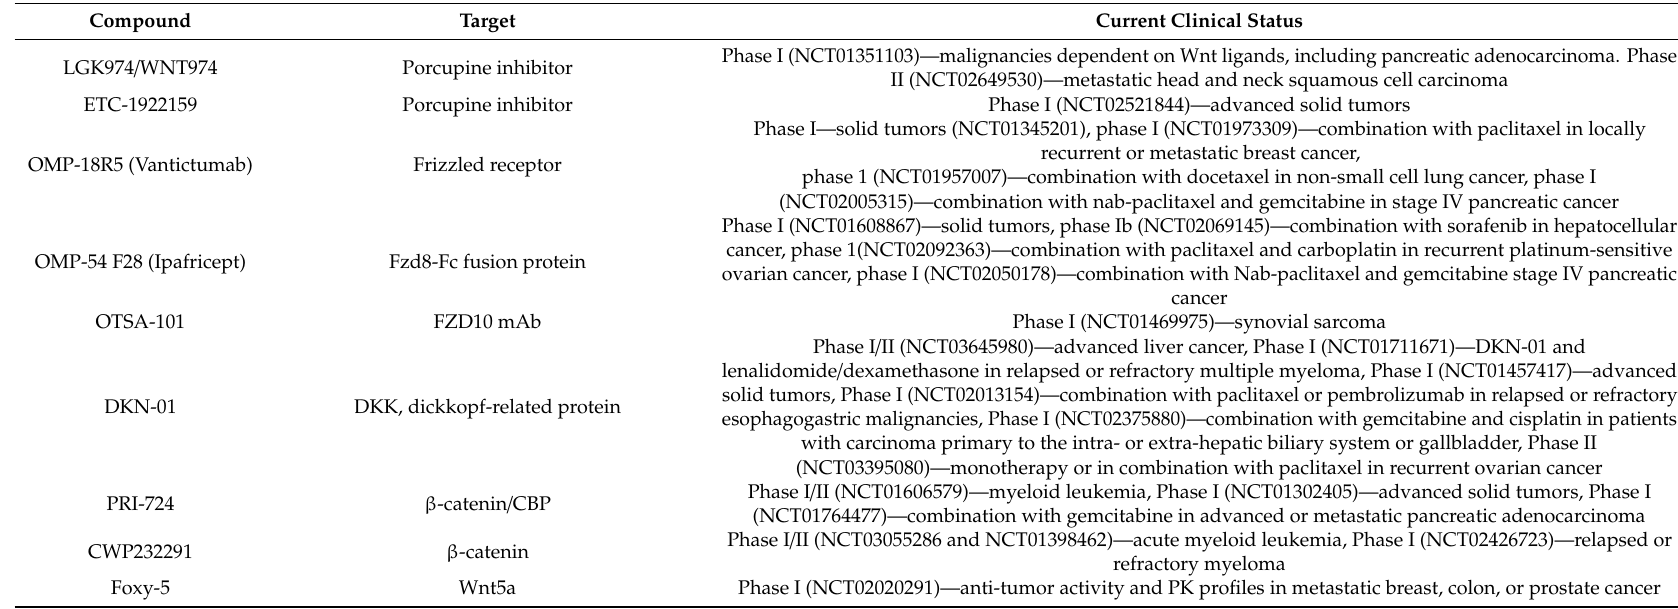
Table 1. Inhibitors for Wnt / β -catenin signaling pathway in clinical